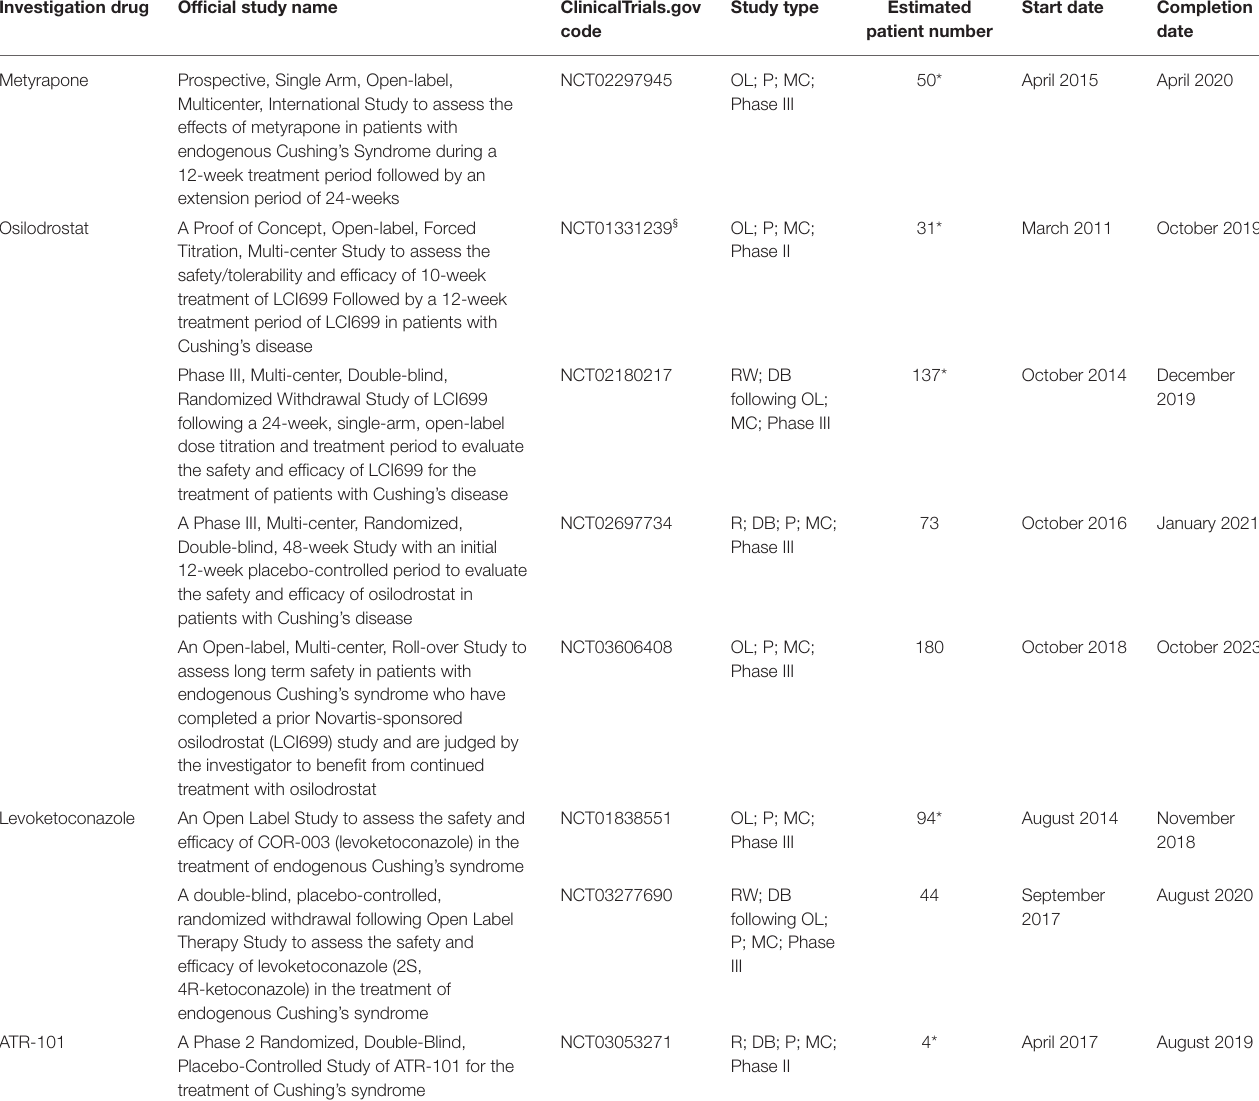
TABLE 3 | Characteristics of current and recent clinical trials, registered in clinicaltrials.gov, on adrenal-directed drugs for the treatment of Cushing’s disease and Cushing’s syndrome in terms of official study name, identification code, study design, patient number, start, and completion